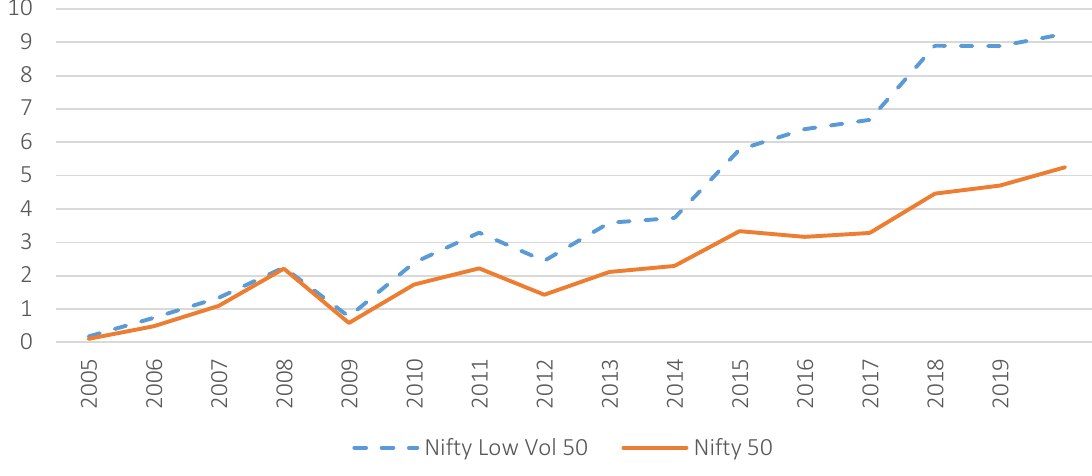
Figure 2. Comparison of returns from Nifty Low-Volatility 50 Index and Nifty 50